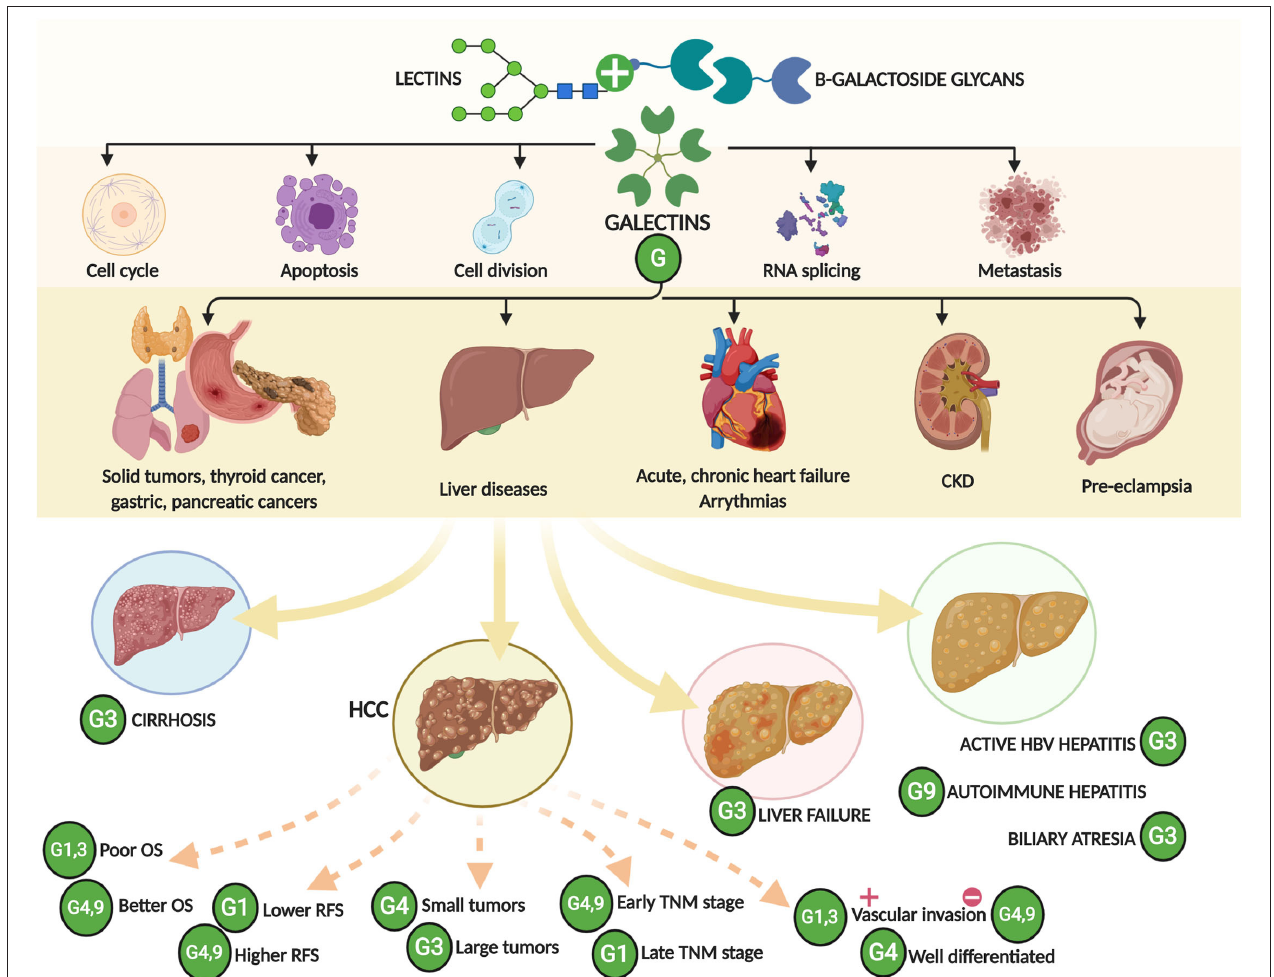
FIGURE 3 | A schematic drawing showing the major findings of this study. CKD, chronic kidney disease; OS, overall survival; RFS, relapse-free survival; HCC, hepatocellular carcinoma; TNM, tumor-node-metastasis.